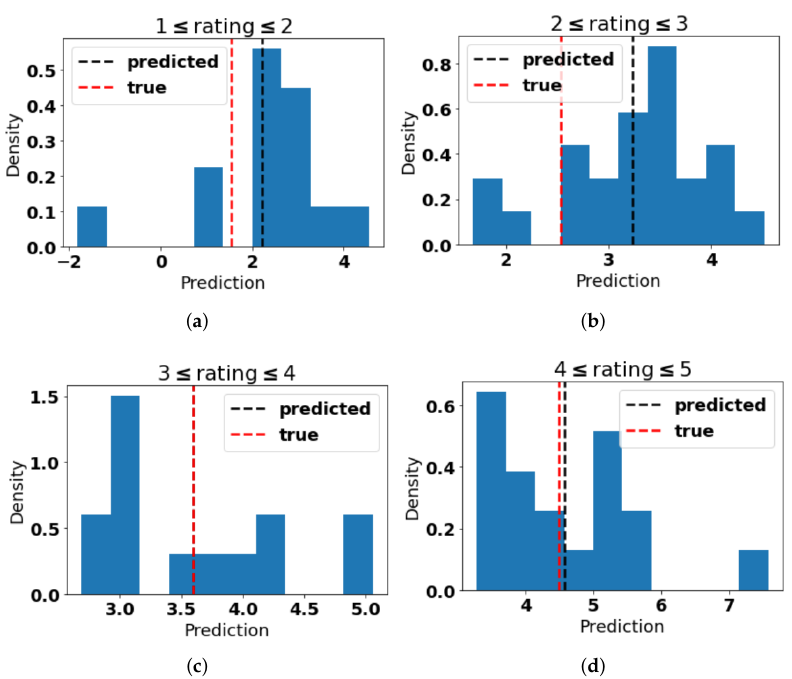
Figure 5. Histograms of the predicted mean rating for various ranges of true ratings ([1, 2] in ( a ), [2, 3] in ( b ), [3, 4] in ( c ), and [4, 5] in ( d )). The vertical dashed lines represent the mean values. The predicted and true means are as follows: 2.206 and 1.543 for ratings in [1, 2], 3.233 and 2.529 for ratings in [2, 3], 3.594 and 3.593 for ratings in [3, 4] (the lines are indistinguishable), and 4.576 and 4.494 for ratings in [4, 5].